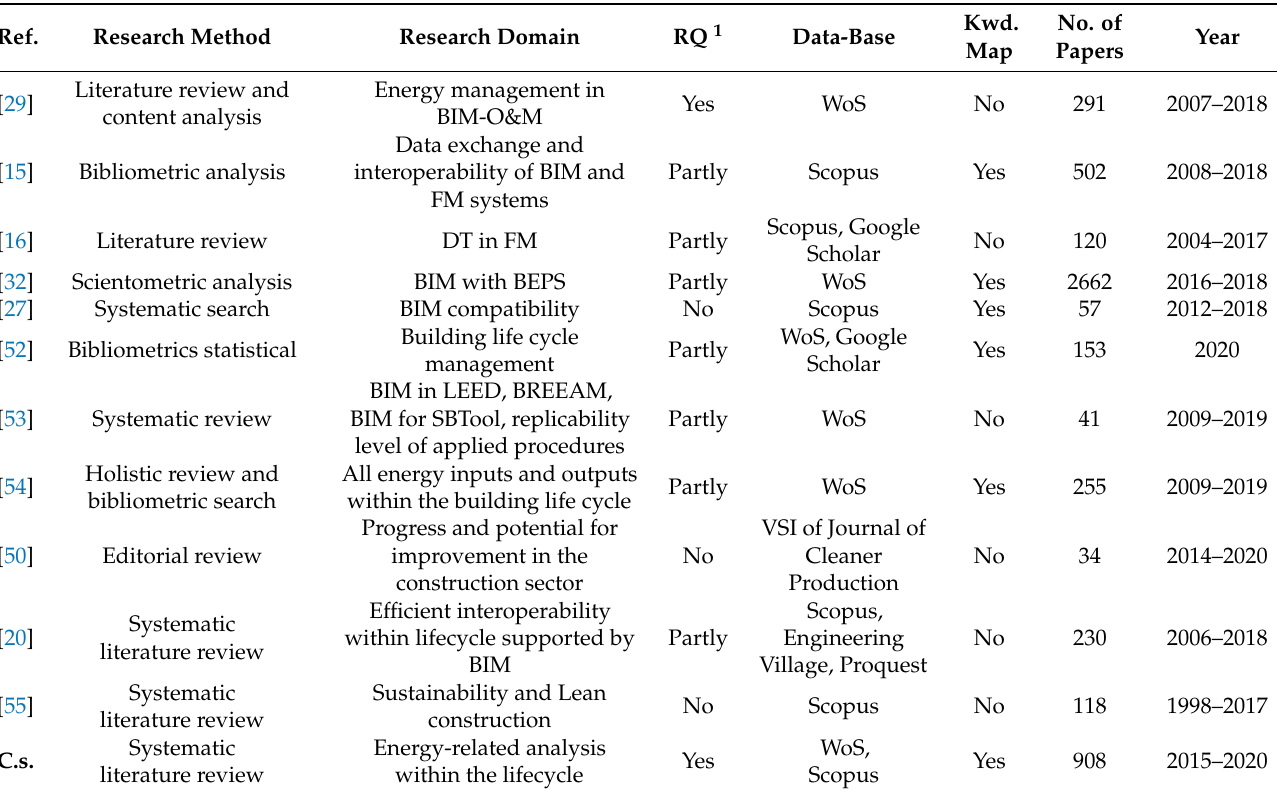
Table 1. Summary of similar reviews on BIM and